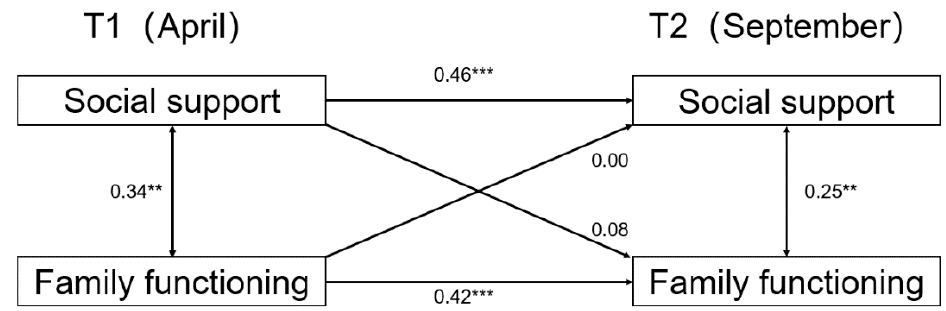
Figure 3. Cross-lagged model for social support and family functioning for boys. Note: statistically significant standardized path coefficients are shown with solid lines. ** p < 0.01. *** p < 0.001.